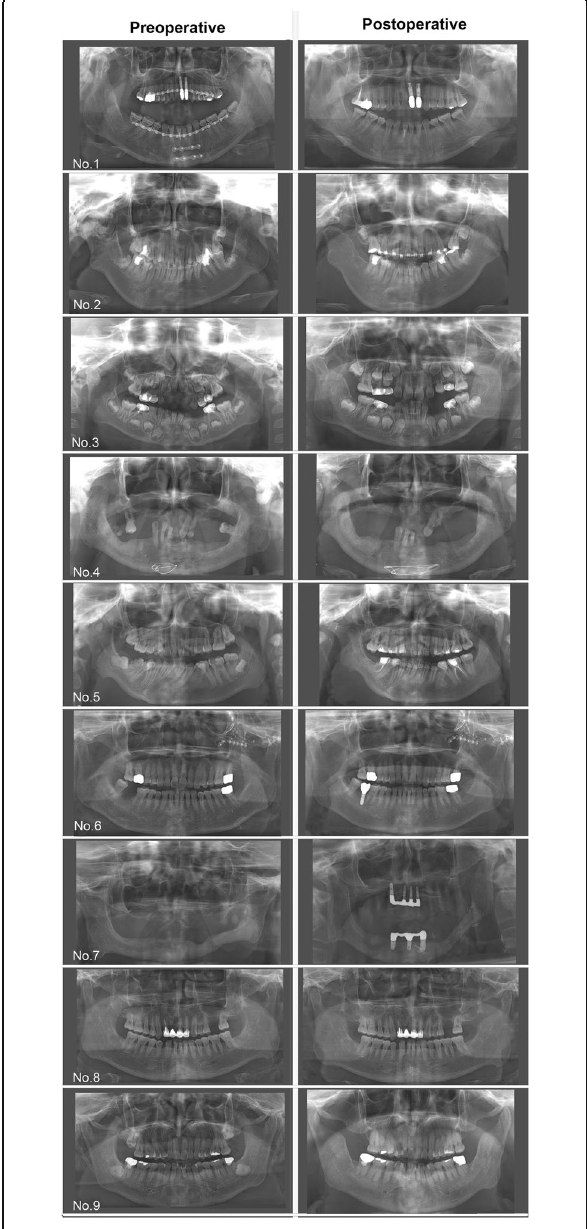
Fig. 6 Preoperative and postoperative panoramic radiograms of nine patients according to each sequential number in Table 1. Each postoperative radiogram is taken on the final follow-up time as shown in Table